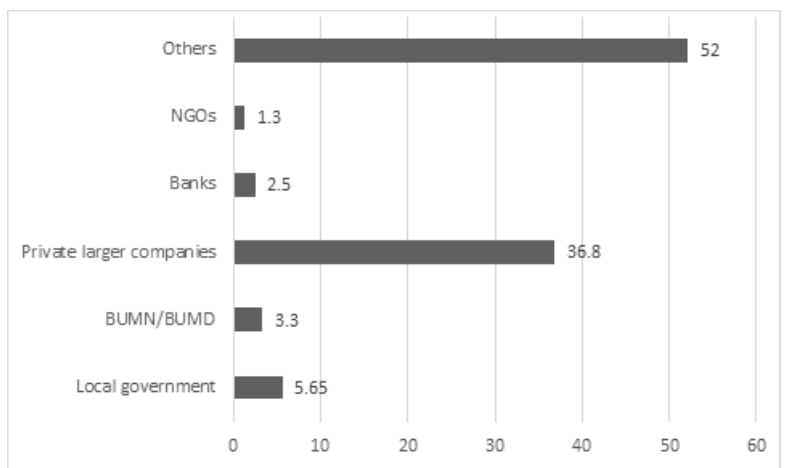
Figure 6: Percentage of Types of Partnership Conducted by MSIs, 2019